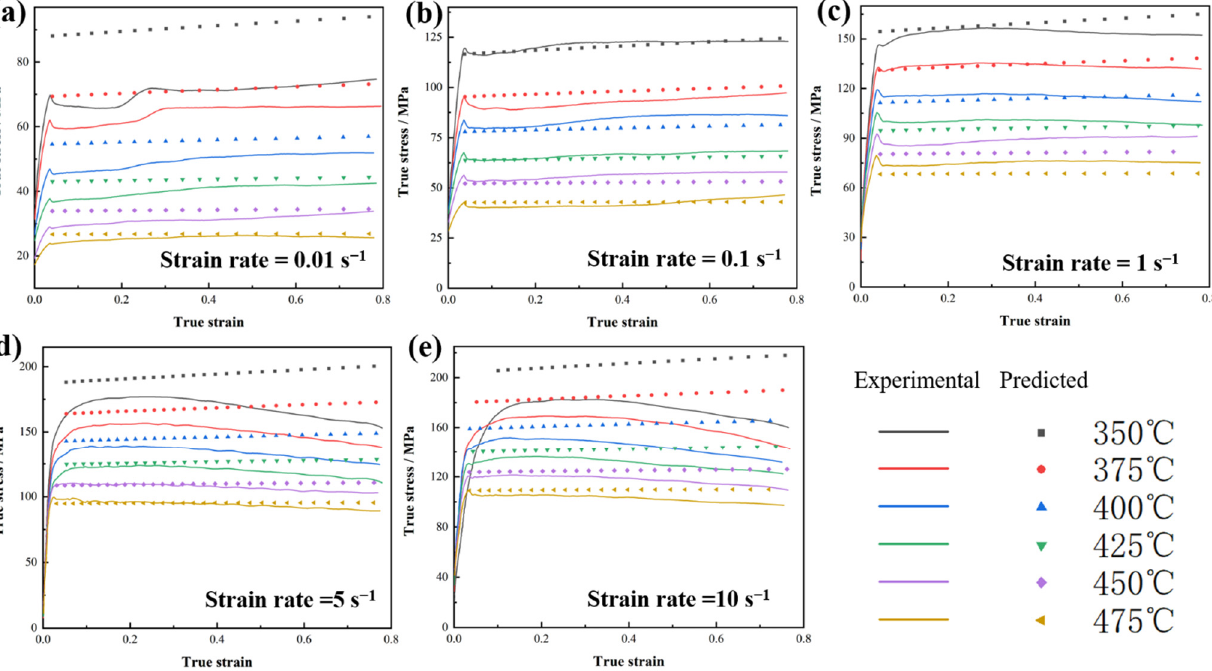
Figure 13. Prediction results of the MZA model with various deformation parameters. ( a ) strain rate = 0.01 s − 1 ; ( b ) strain rate = 0.1 s − 1 ; ( c ) strain rate = 1 s − 1 ; ( d ) strain rate = 5 s − 1 ; ( e ) strain rate = 10 s − 1 .